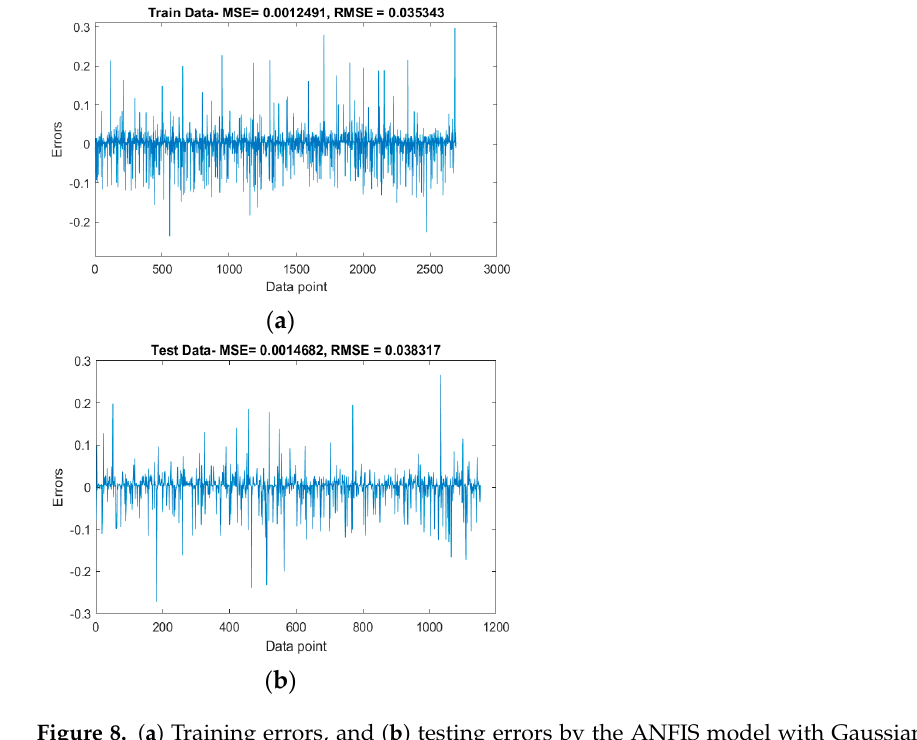
Figure 8. ( a ) Training errors, and ( b ) testing errors by the ANFIS model with Gaussian membership functions.